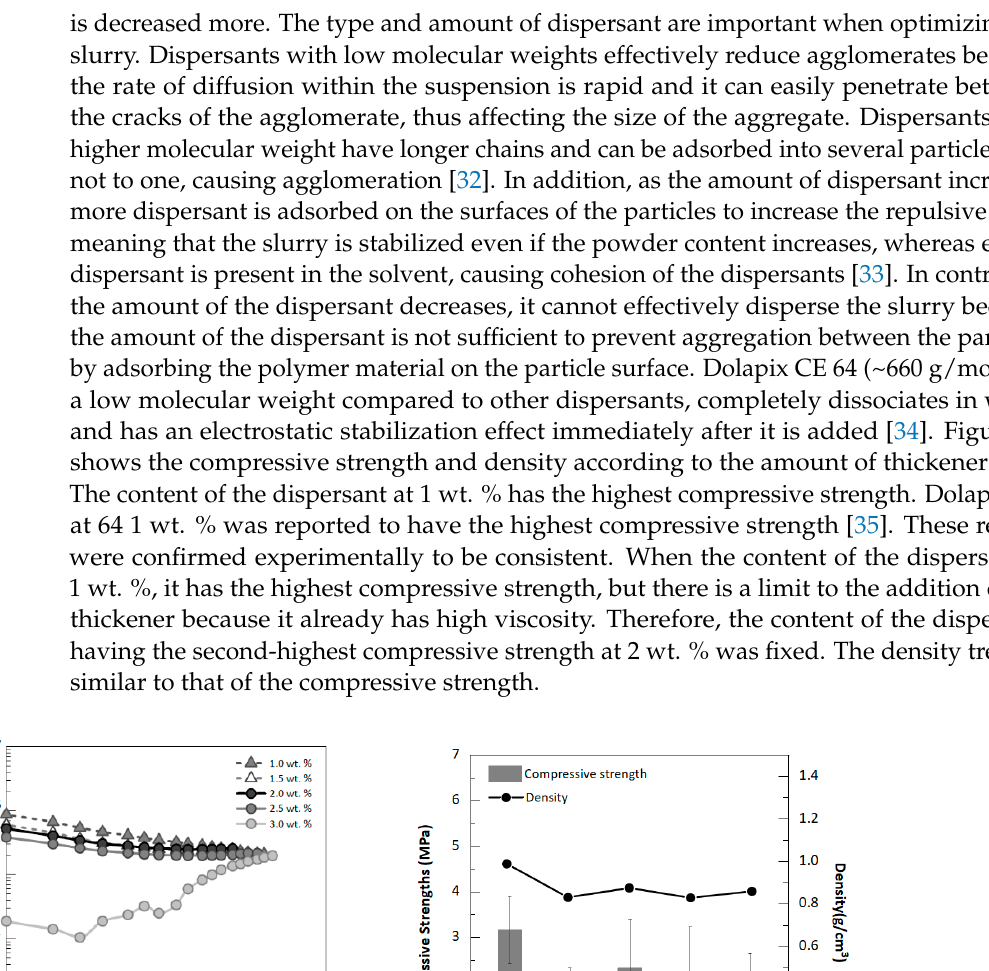
( b ) Figure 10. (a) Viscosities of the ZTA slurries with different amounts of thickener, and (b) compres- sive strengths and density levels of the ZTA slurries depending on the amount of thickener used .